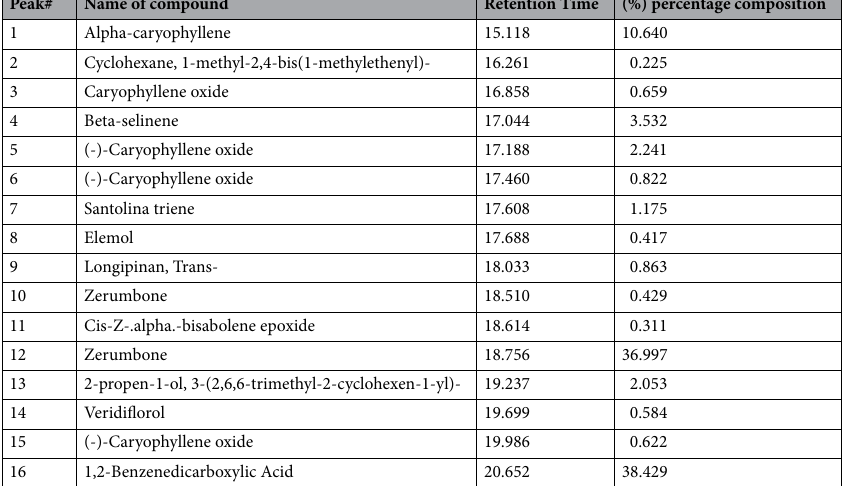
Table 1. Chemical constituents of MEZZR.